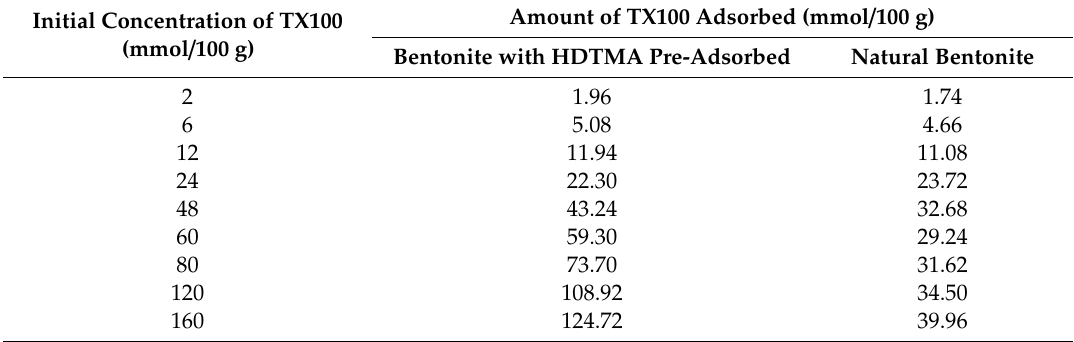
Table 1. The amount of Triton X-100 (TX100) adsorbed onto natural bentonite and bentonite with pre-adsorbed hexadecethyltrimethylammonium